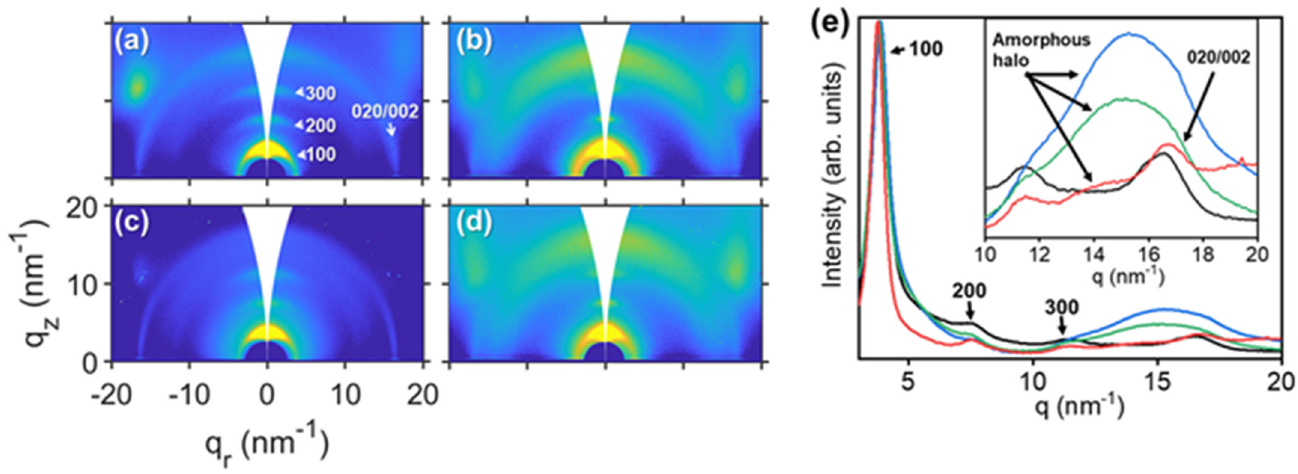
Figure 5. GIWAXS patterns of ( a ) P3HT thin film non-irradiated, and irradiated: ( b ) squares ~500 nm, ( c ) squares ~200 nm, ( d ) rectangles. ( e ) Azimuthal integrated intensity profiles of the GIWAXS pattern: non-irradiated thin film of P3HT (black curve), squares ~500 nm (red curve), squares ~200 nm (blue curve) and rectangles (green curve). GIWAXS of irradiated samples taken with X-ray beam parallel to first irradiation. Inset shows a magnification of the q-range region where the 020/002 reflection and amorphous halo of P3HT appear. Main reflections of crystalline P3HT labeled. Intensity of GIWAXS patterns in logarithmic scale.